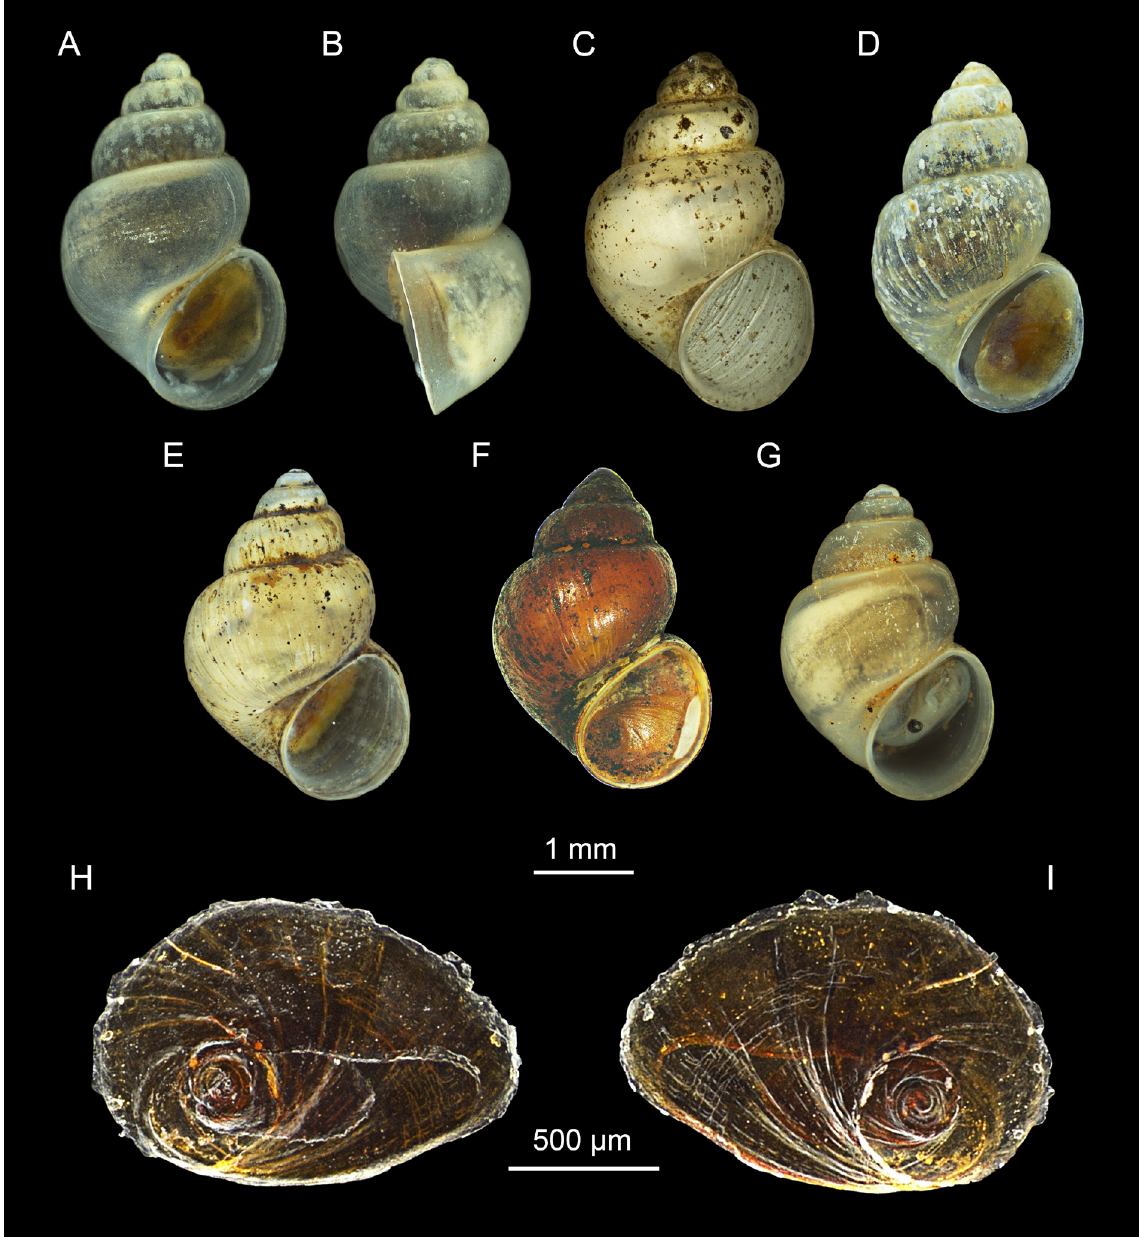
Fig. 8. Shells and operculum of Mercuria tachoensis (Frauenfeld, 1865) . A–B . Spring at Saô Mamede, Leiria, Portugal. C . Oude Maas at Hoogvliet, Netherlands. D . Das Mouras Spring, Alpedriz, Leiria, Portugal. E . Arun Banks, Burpham, West Sussex, United Kingdom. F . Spring at Vale de Lobos, Almargem do Bispo, Lisboa, Portugal. G–I . Spring at Jardim da Sereia, Coimbra, Portugal. H . Operculum, inner side. I . Operculum, outer